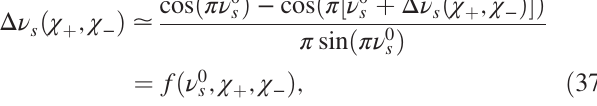
χ ; χ − Þ . Note the difference of the vertical scales for the two s ð þ